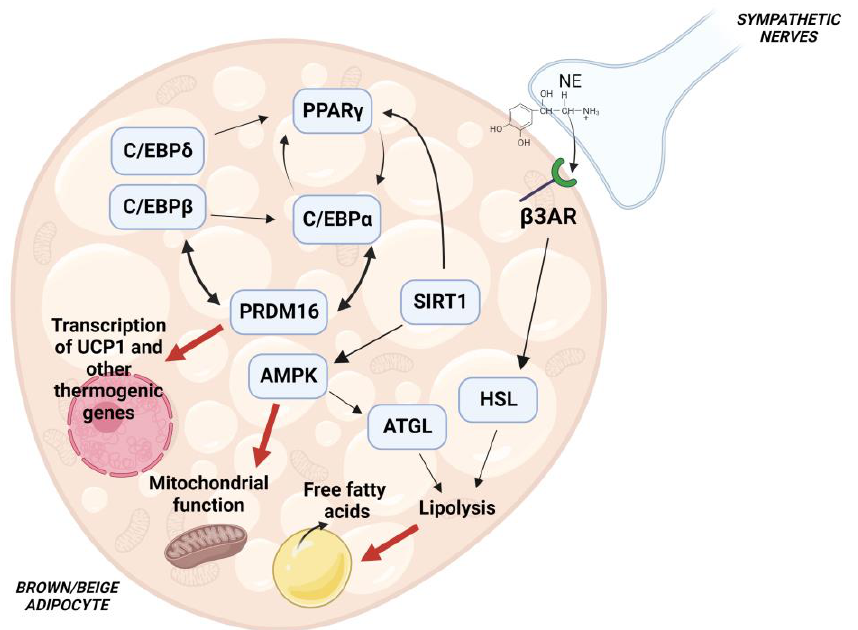
Figure 1. Molecular pathways regulating brown/beige adipocyte differentiation. Cooperation of PPARγ with C/EBPs is crucial for an optimal differentiation. PRDM16 promotes a thermogenic program thorugh interaction with C/EBPs and PPARγ, and loss of PRDM16 results in defective BAT formation. SIRT1 has been shown to deacetylate PPARγ. SIRT1 - mediated deacetylation of PPARγ stimulates its interaction with PRDM16, leading to increased expression of brown and beige fat-specific genes. SIRT1 has also been shown to activate AMPK, a key enzyme involved in energy homeostasis. Activation of AMPK contributes to mitochodrial function by regulating the process of mitophagy, and stimulates ATGL activity to increase lipolysis. β -adrenergic receptor activation also stimulates lipolysis, with subsequent release of free fatty acids which promote mitochondrial β -oxidation and direct activation of UCP1.